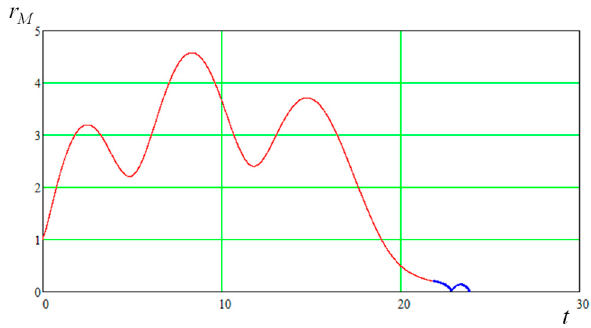
Figure 27. Selenocentric energy h Moon [undim.] along the optimal flight trajectory.